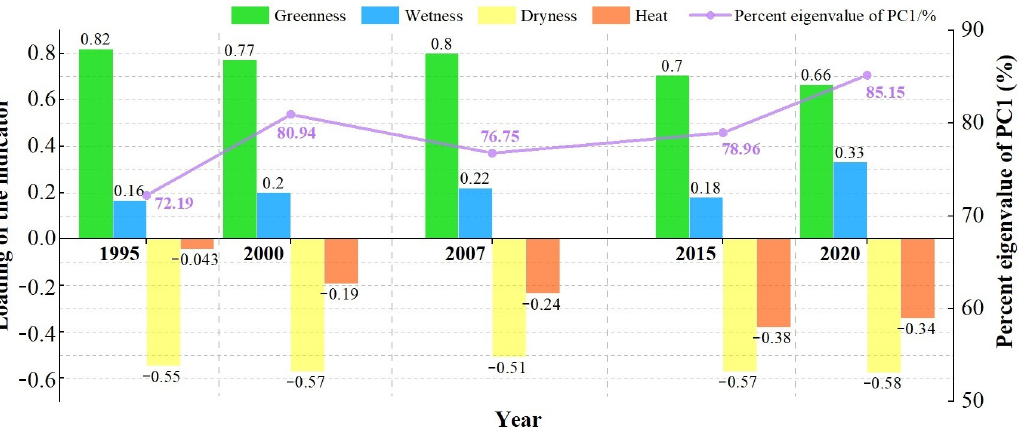
Figure 3. Information of the Principal Component Analysis (PCA) transformation for each